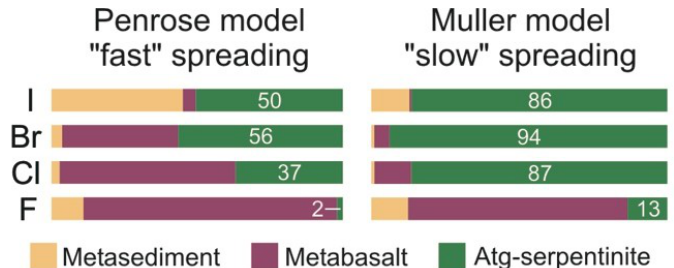
Figure 6. Summary of F, Cl, Br and I budget calculations for a metamorphosed slab according to Penrose-type and Muller-type models of oceanic lithosphere. See Figure 4 for descriptions of unit thicknesses. Average halogen concentrations for each unit are reported in Table 1. Numbers in bars denote the percent contribution of serpentinite to the total residual halogens in the slab.